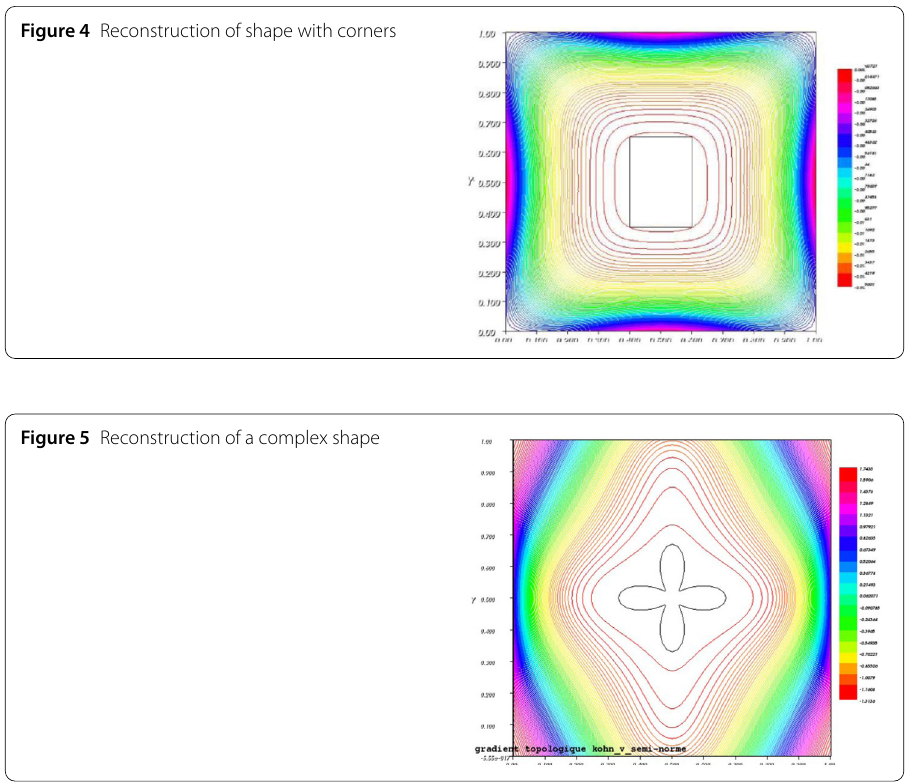
Figure 4 Reconstruction of shape with corners